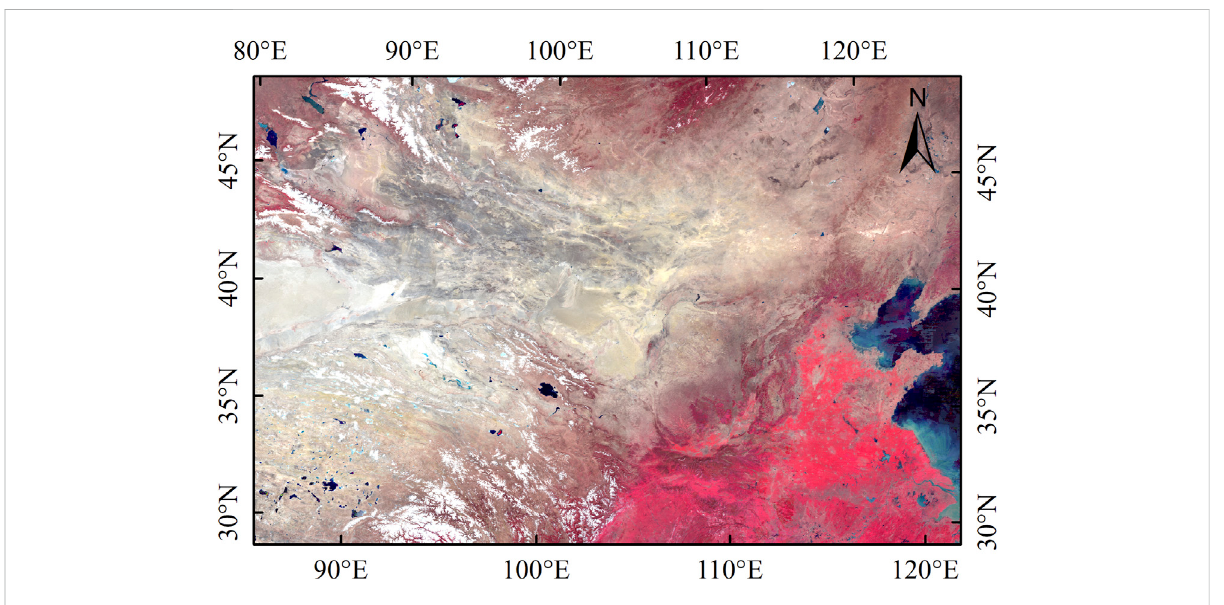
FIGURE 1 Standard false-color composite image of LSR in April 2014